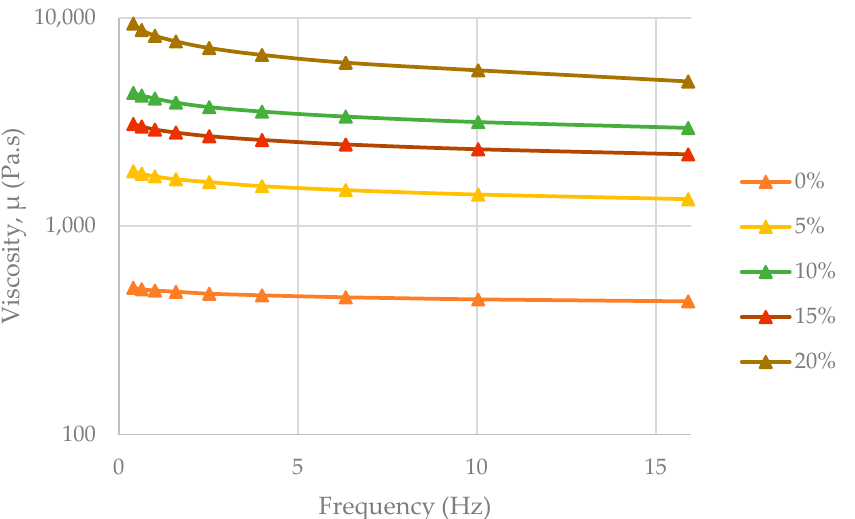
Figure 3. Representative plot of viscosity (µ) versus frequency at 60 °C at varying concentrations of TLA/TBP blend with toner D additive.